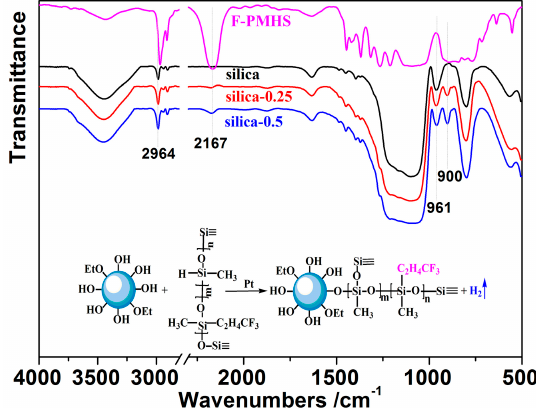
Figure 1. FTIR spectra of PMHS, pure silica xerogel, and xerogel modified with F-PMHS content of 0.25% and 0.5%.